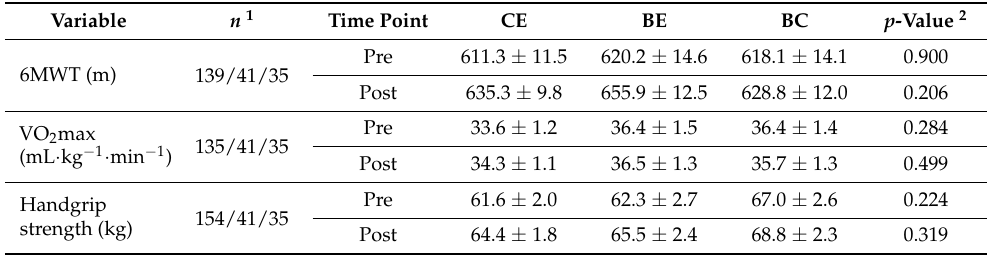
Table 7. Physical performance variables compared among groups over time. Data expressed as least squares mean ±